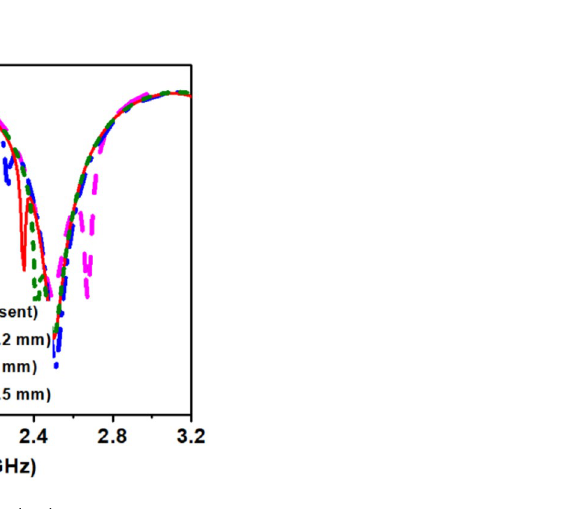
Figure 7. Effect of length ( l 9 ) of stub- 2 on |S 11 |.